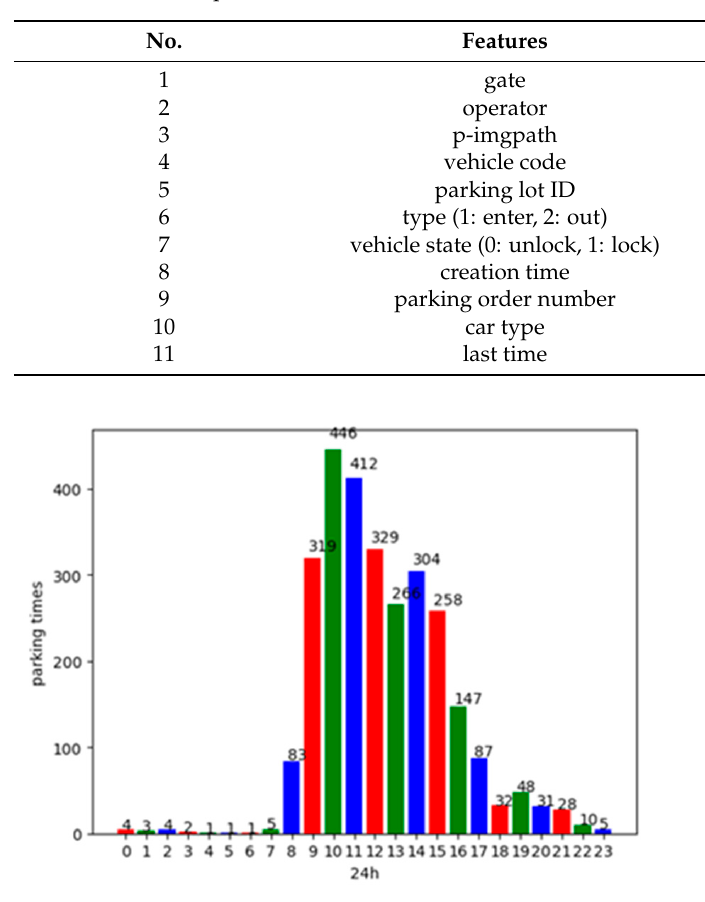
Figure 2. The distribution of vehicles’ parking times.